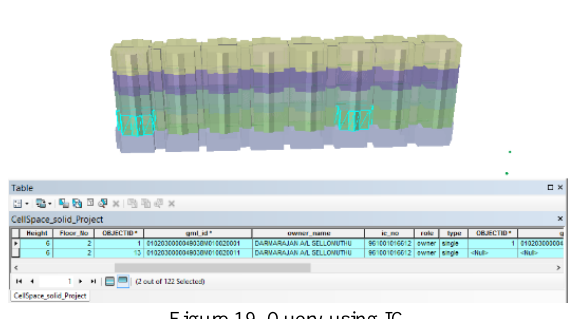
Figure 19. Query using IC